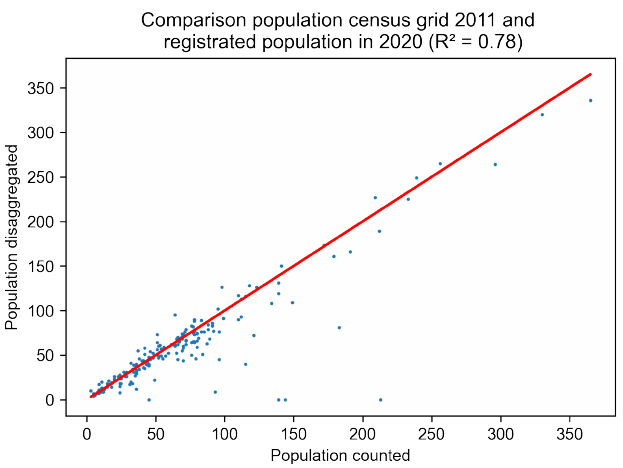
Figure 19. Comparison census population from 2011 and recorded population